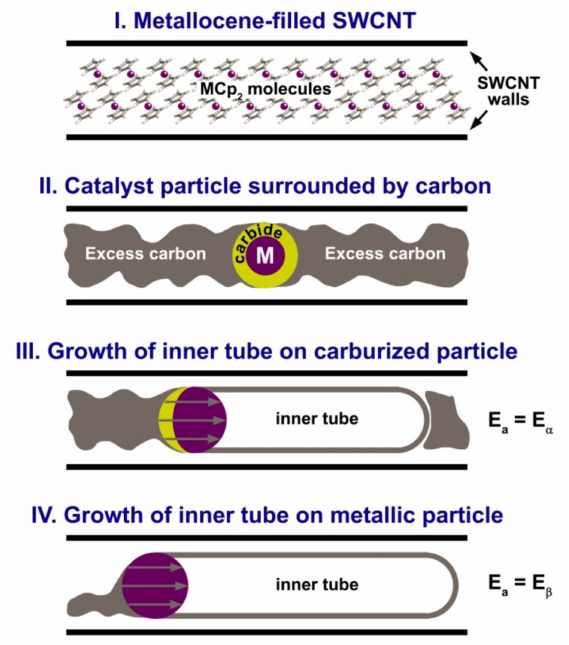
Figure 17. Illustration of the growth model of the inner tubes inside the metallocene-filled SWCNTs. MCp 2 (M = Ni, Co) molecules encapsulated into the channel of SWCNT (step I) are decomposed upon annealing. As a result, carburized metal nanoparticles surrounded by excess carbon are formed (step II). They act as a catalyst for the inner tube growth (step III). Carbon diffuses from one side to other side of the catalyst particle through its bulk (as shown by arrows), and the inner nanotube grows with the activation energy E a = E α . When the amount of excess carbon becomes insufficient to restore the decomposing metastable metal carbide, the growth of the inner tube continues on the metallic catalyst nanoparticle (step IV). Carbon diffuses through the bulk of the particle (as shown by arrows), and the nanotube is formed with the activation energy E a = E β . The growth stops when there is no more carbon